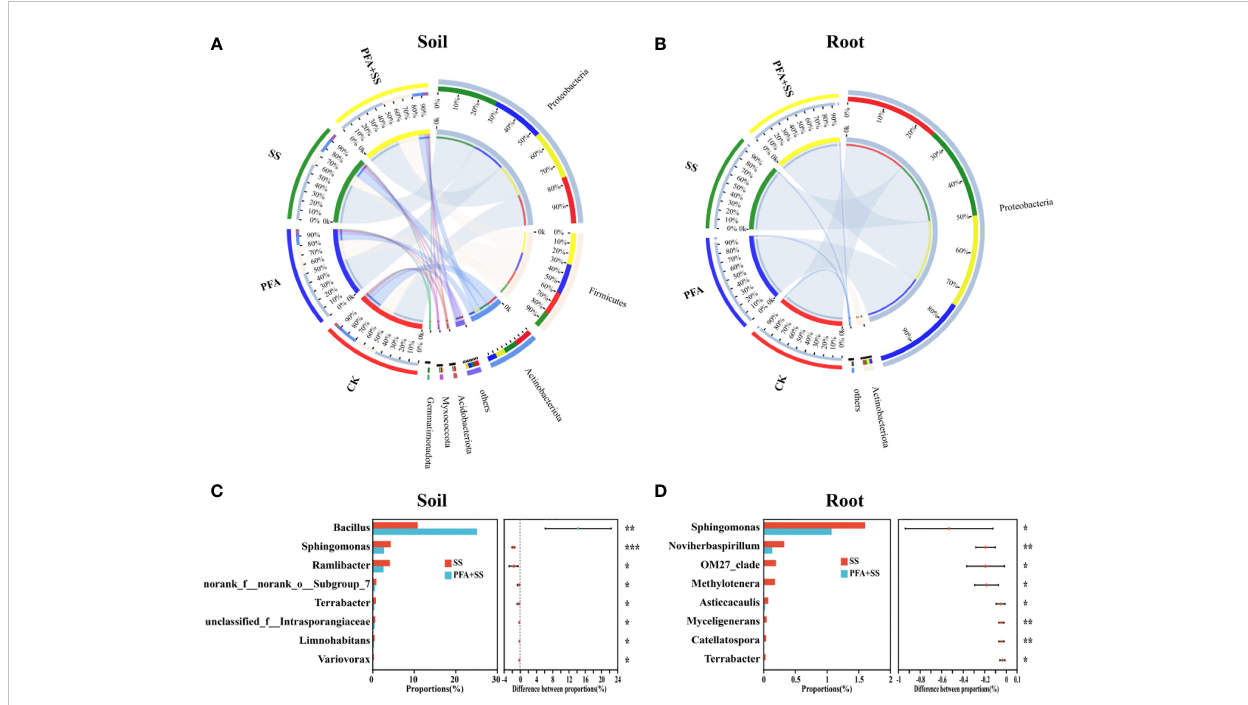
FIGURE 5 The relative abundance and composition of bacterial communities in the rhizosphere soil (A) and root (B) samples at the phylum level, the signi fi cance comparisons of bacterial communities in the rhizosphere soil (C) and root (D) samples at the genus level. CK, the seedlings without PFA and salt stress; PFA, the seedlings amended with PFA and without salt stress; SS, the seedlings with salt stress; PFA+SS, the seedlings amended with both PFA and salt stress. * p <0.05, ** p <0.01, and *** p